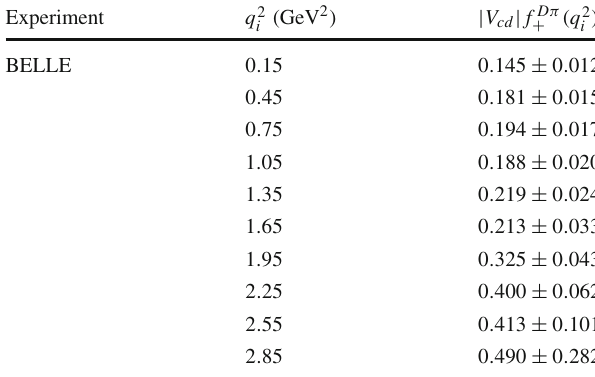
Table 7 Values of | V cd | f D π + ( q 2 collected in Ref. [18]